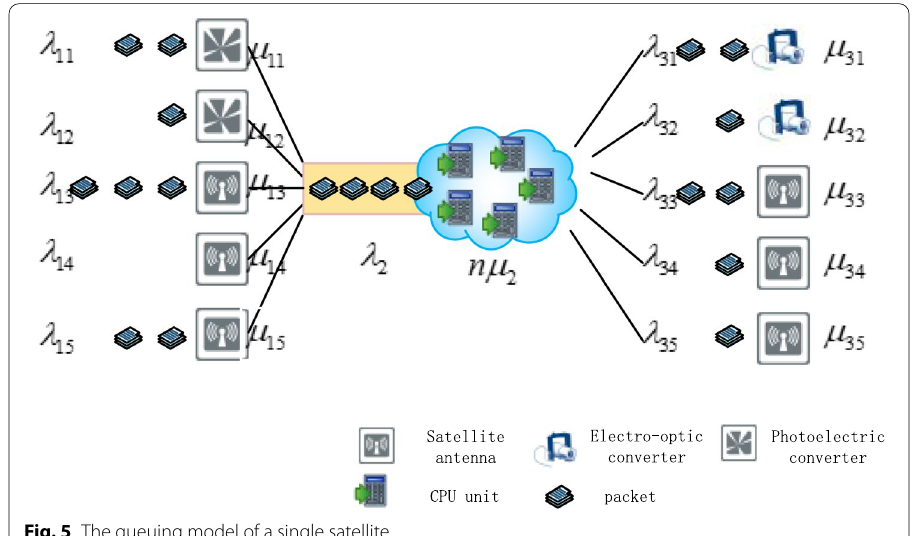
Fig. 5 The queuing model of a single